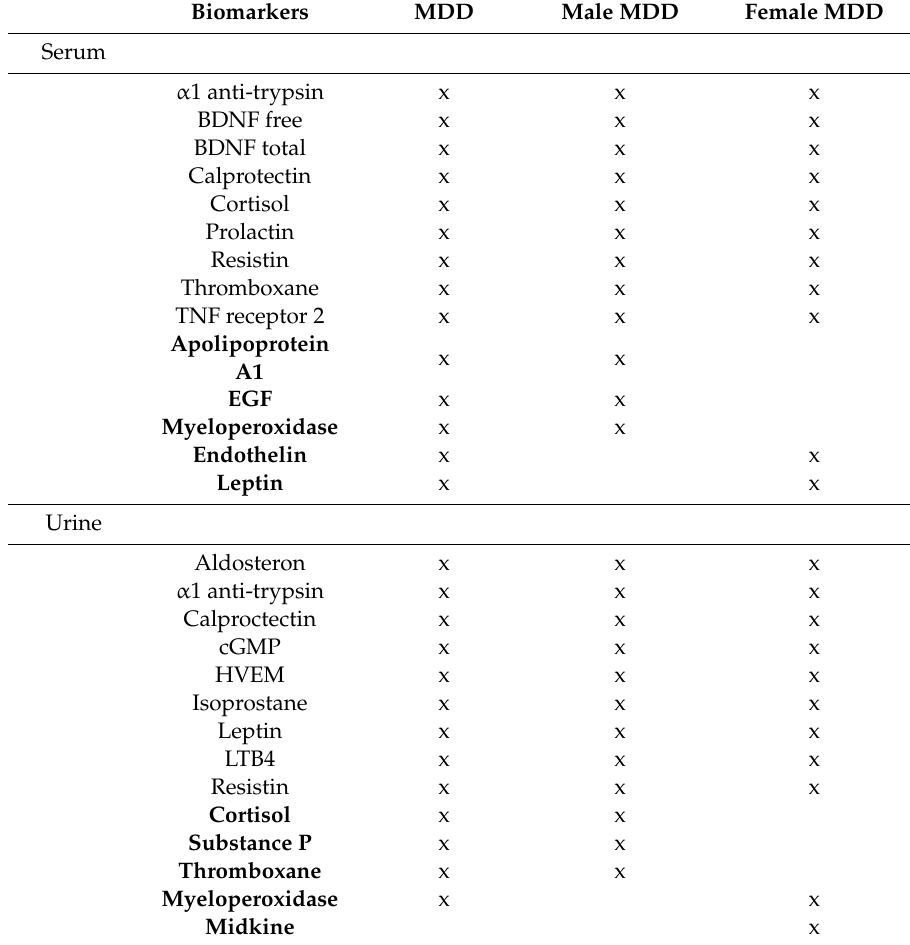
Table 5. Overview of biomarkers actively contributing to the AUC of the bio depression score. Biomarkers MDD Male MDD Female